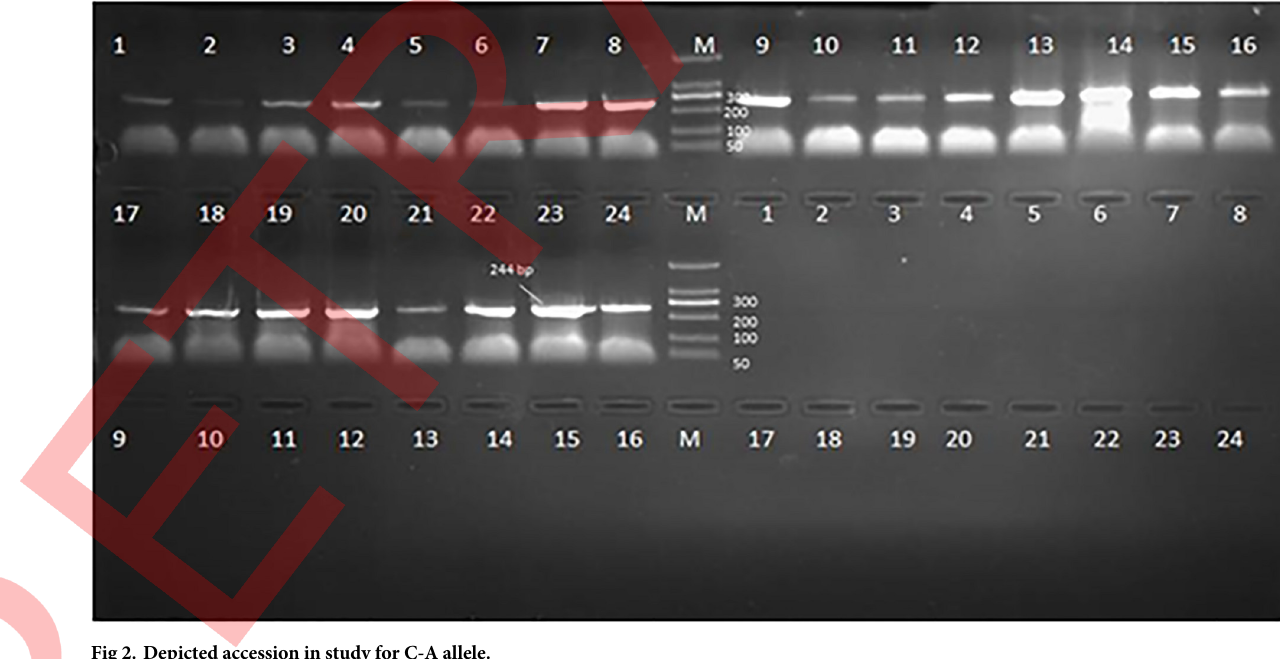
SPL14-12 C-A allele genotyping PCR amplification was carried out for C-A allele in fragment size of 244bp and 302bp. All the accessions carry a C allele in fragment size of 244bp. C-A allele was located on third exon of OsSPL14 , which is the target site of OsmiRNA156. OsmiRNA156 is a free miRNA that cleaves the mRNA transcript of the OsSPL14 gene. Rachna basmati, Basmati 370, IR9, 77, KSK 434,